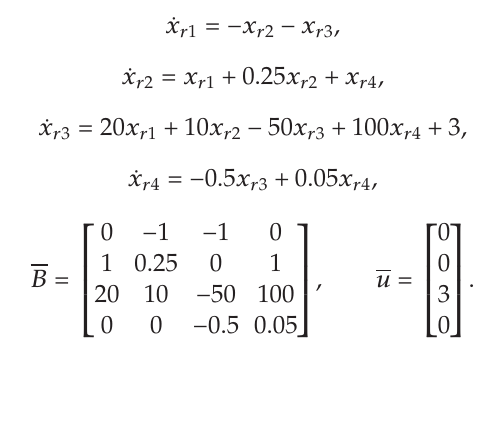
Figure 3: The estimation of the uncertain parameters: (cid:6) a (cid:7) (cid:6) a is the estimation of a ; (cid:6) b (cid:7) (cid:6) b ; (cid:6) c (cid:7) (cid:6) c is the estimation of c ; (cid:6) d (cid:7) d is the estimation of d . The reference model is the same as Example